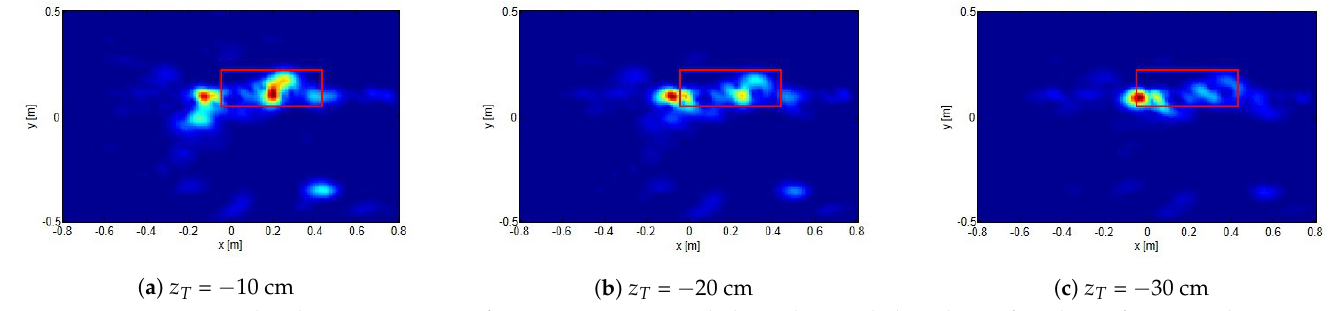
Figure 10. Normalized reconstructions of a target approximately buried 10 cm below the air/sand interface. Data have been collected over 4 × 4 measurement grid with a spatial step of 40 cm and offsetx = 1.7 m, offsety = 0.0 m. The actual target location is denoted as red rectangles. Comparison of reconstructions obtained using N k = 7 at different